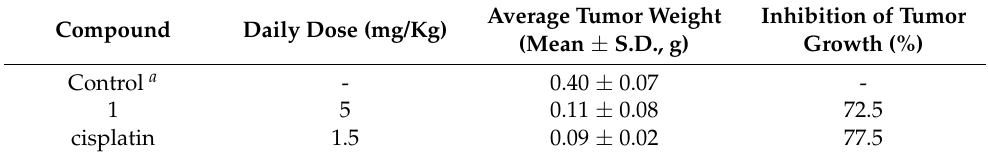
Table 1. a Vehicle (0.5% ( v / v ) of DMSO and 99.5% ( v / v ) of 0.9% NaCl in water). In vivo antitumor activity. Lewis lung carcinoma (LLC) was implanted i.m. (2 × 10 6 cells inoculum) into the right hind leg of 8-week-old male and female C57BL mice (24 ± 3 g body weight). Chemotherapy was delayed